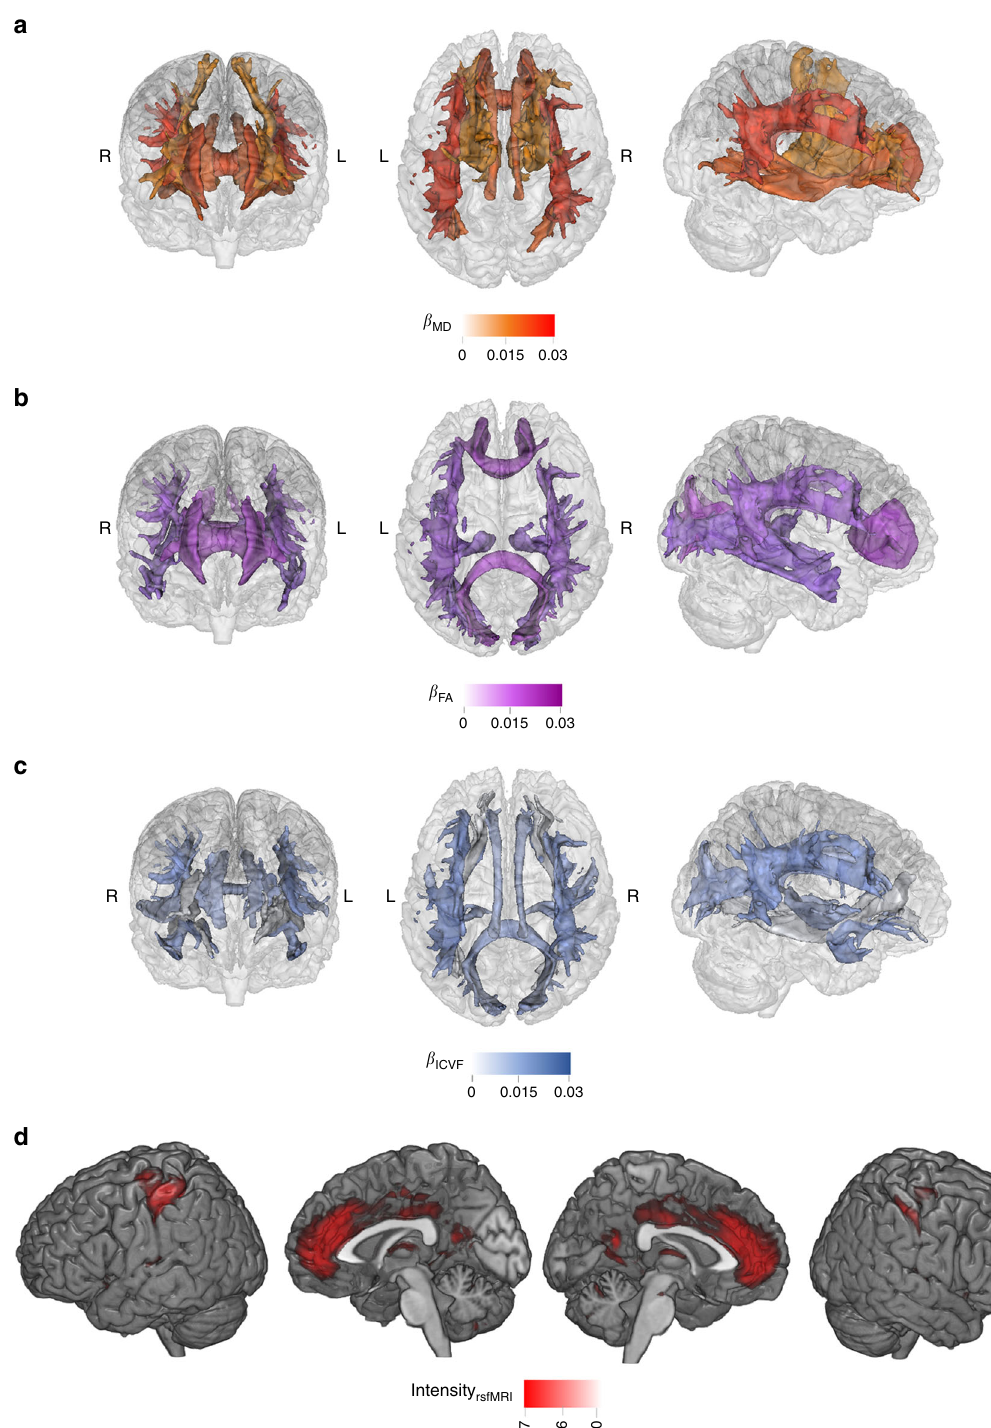
Fig. 4 Maps for the signi fi cant associations between depression-PRS and brain phenotypes. a – c are the brain maps for the signi fi cant associations between depression-PRS and white matter microstructure in fractional anisotropy (FA; a ), mean diffusivity (MD; b ) and intra-cellular volume fraction (ICVF; c ) of major tracts. The shade for each tract represents the standardised effect size ( β ), with a darker shade showing a greater mean β across all depression-PRS at different p thresholds (pT). From left to right are from anterior, superior and right view. For clarity, among the tracts presented in Fig. 2, the ones that showed consistent associations across at least four depression-PRS pT are presented. d shows the brain maps for regions involved in signi fi cant associations between resting-state fl uctuation amplitude and depression-PRS. Regions that show consistent associations across at a minimum of four depression-PRS p thresholds are presented. Visualisation of results is achieved by calculating the average intensity of ICA maps, weighted by their mean β across the pT. For clarity, the brain maps shown below have a threshold applied on (intensity over 50% of the highest global